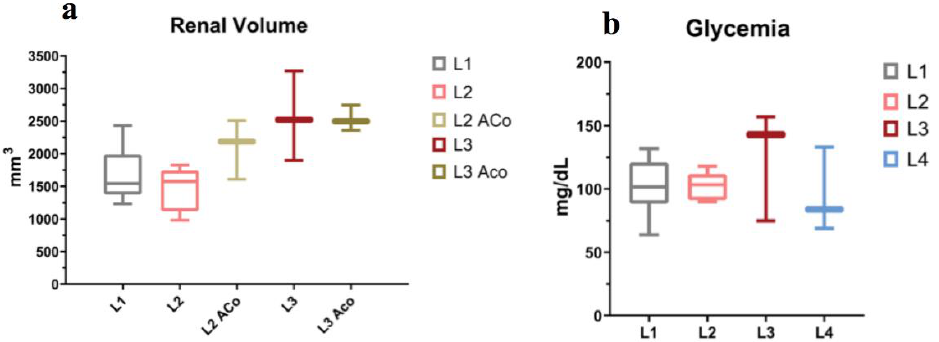
Figure 5. ( a ) Influence of doxorubicin on kidney volumes right after completion of the 6 weeks course (L2) and after another 6 weeks from regimen termination (L3) and their age-matched coun- terparts; ( b ) Pre-scan blood glucose levels within acceptable range for 18 F-FDG PET study (<200 mg/dL), with a tendency towards the upper limit for cardiorenal rats.